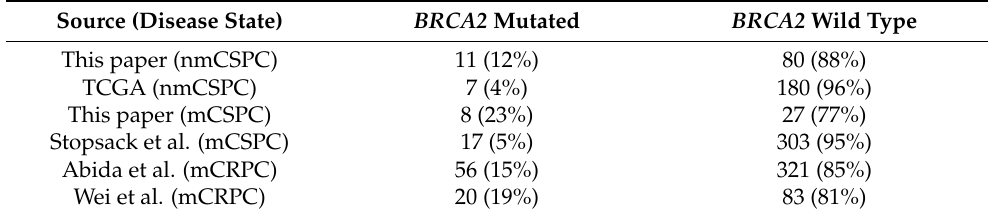
Table 3. BRCA2 mutation incidences in prostate cancer datasets with PSA level data